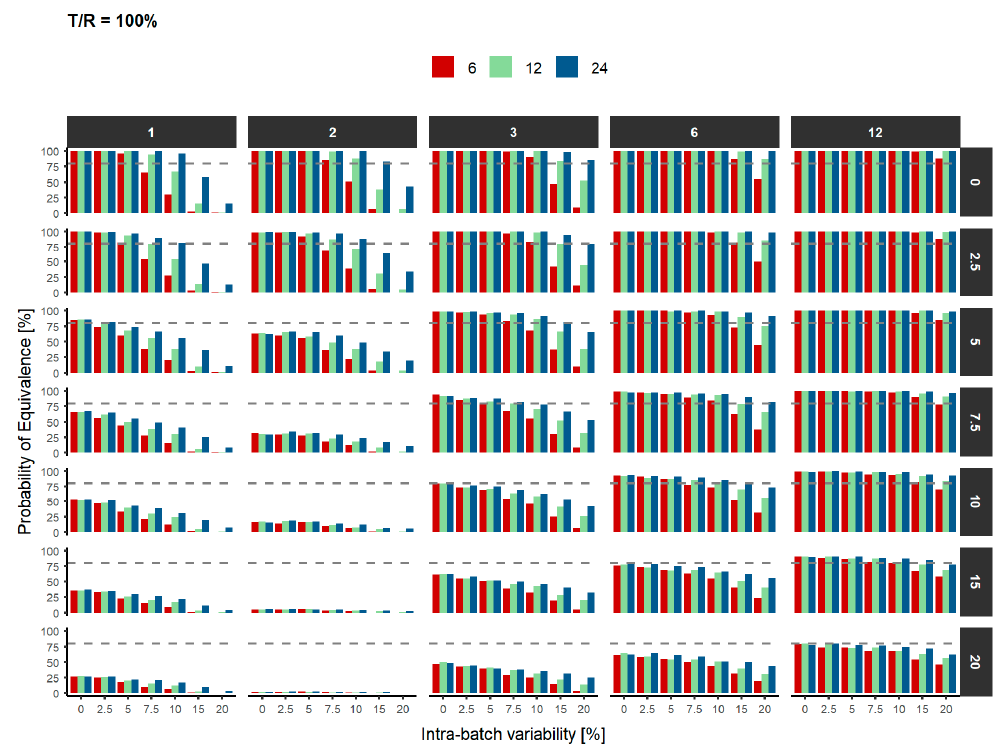
Figure 3. Probability of declaring similarity based on the intra-batch variability and the number of units (red: 6, green: 12 and blue: 24). Top panels represent the number of batches and right panels represent the inter-batch variability. The grey dashed line represents the statistical power to declare equivalence between both products (80%).